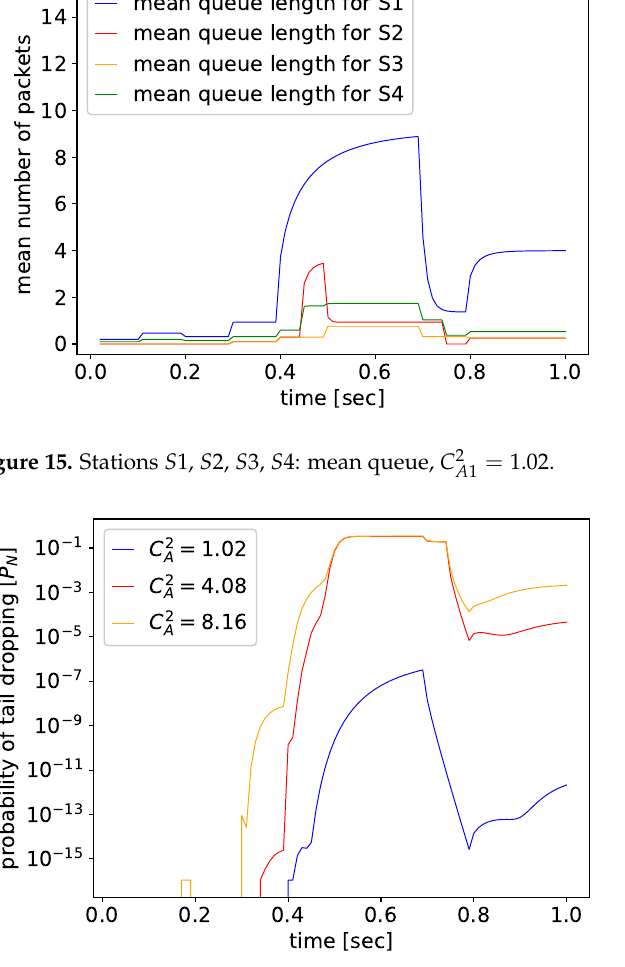
Figure 16. Total loss probability for path S 1 − S 3 − S 4 for different C 2